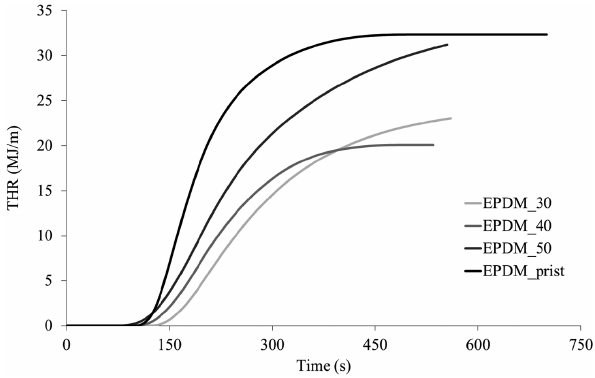
Figure 5: Total heat release (THR) curves of samples studied.